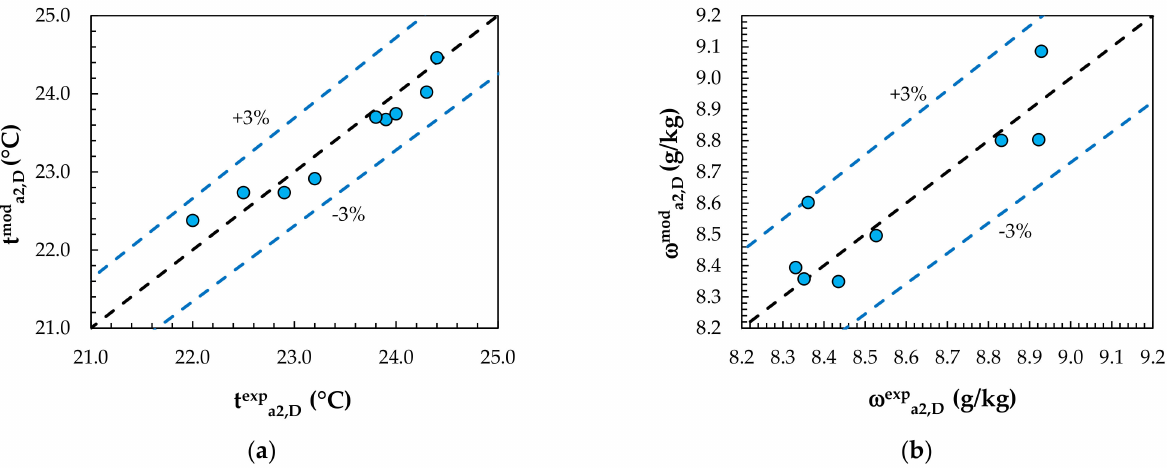
Figure 6. Comparison of model values with experimental results for dehumidification: ( a ) outlet air temperature; ( b ) outlet air humidity ratio.